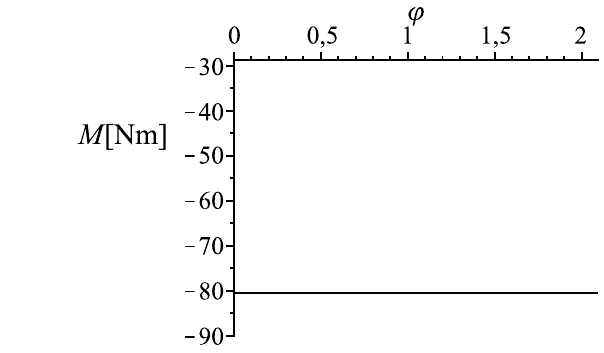
Figure 15: The plot of ϕ 2 = ϕ 2 ( φ ) .